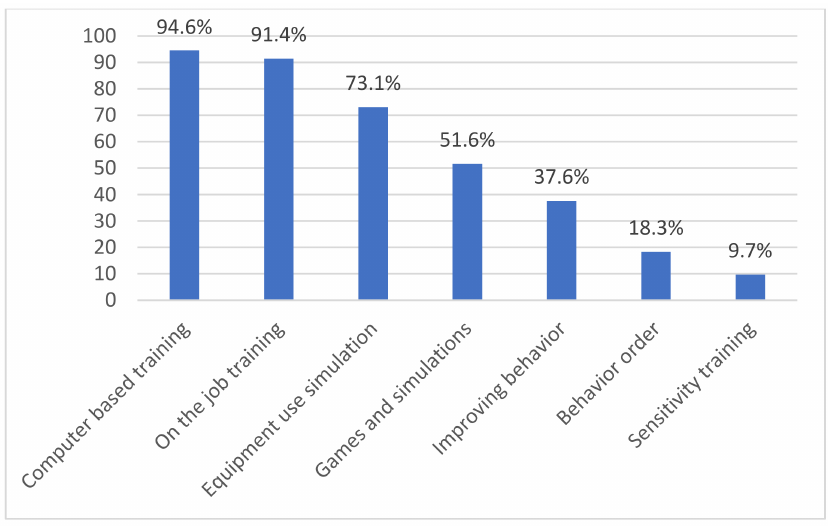
Figure 9. Safety training methods used in safety training